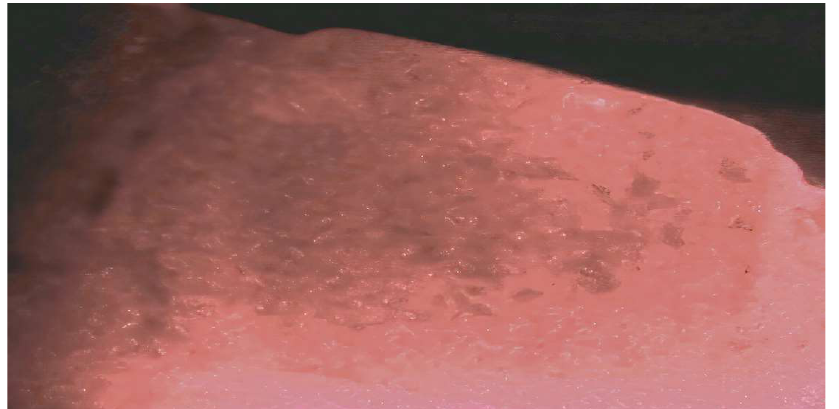
Figure 1. Microislands of calculus remaining on a root surface after ultrasonic and hand scaling until the root of the extracted tooth was deemed calculus free when visualized with 3.5× magnification loupes. The root surface is illuminated with a 655 nm laser to aid visualization of calculus. (Videoscope photo 40× magnification).